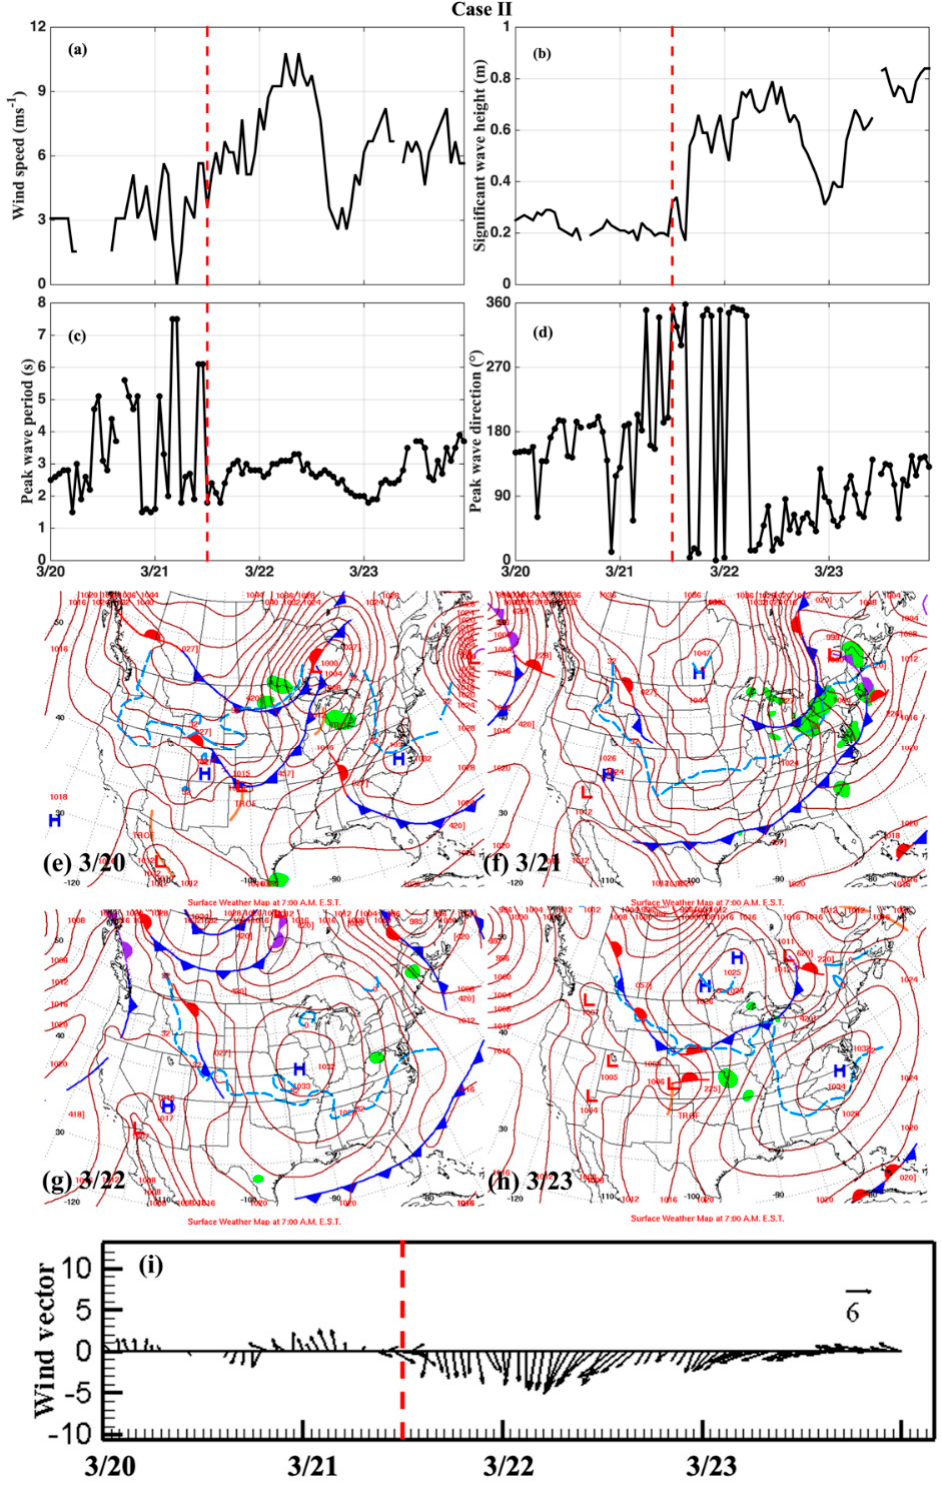
Figure 8. Case II: Time series of ( a ) wind speed (ms − 1 ), ( b ) significant wave height (m), ( c ) peak wave period (s), ( d ) peak wave direction ( ◦ ), ( e – h ) surface weather map on 12:00 UTC from 20 to 23 March and ( i ) wind vectors from the station WS. The red vertical dashed lines indicate the timing of the cold fronts.